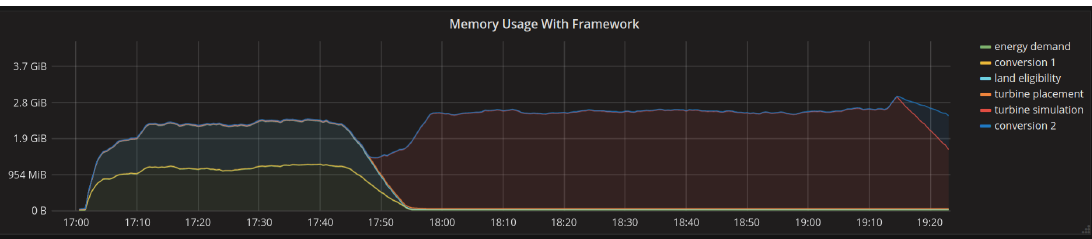
Figure 8. Memory usage of the different processes within the framework.